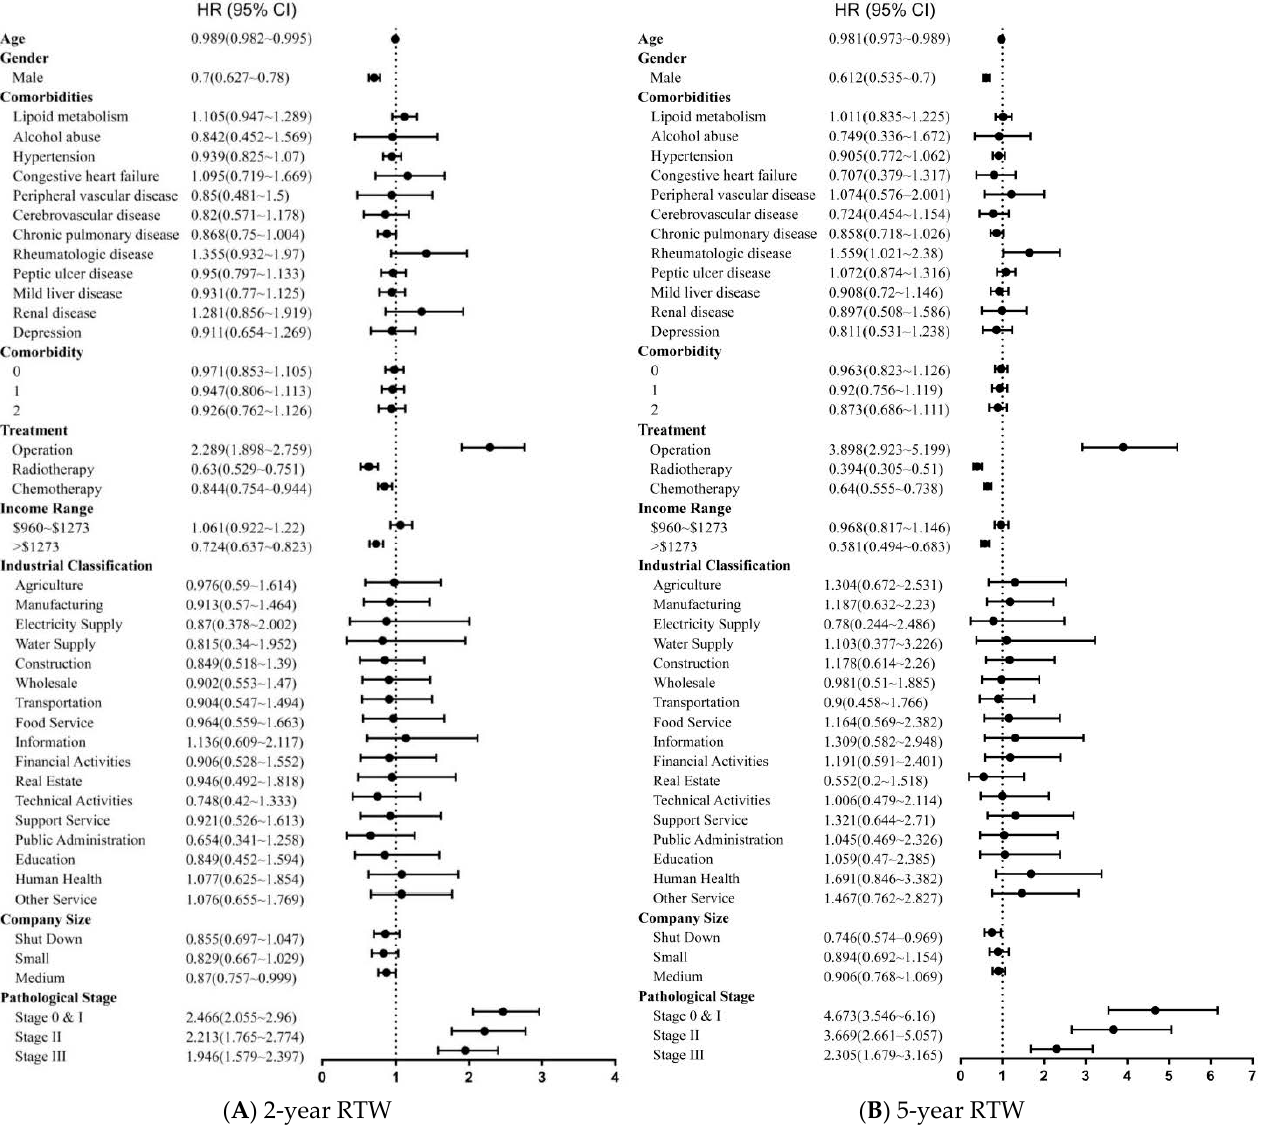
Figure 2. Forest tree plot showing the HR obtained by univariate Cox proportional hazards model of return to work for lung cancer survivors in ( A ) 2-year RTW and ( B ) 5-year RTW.